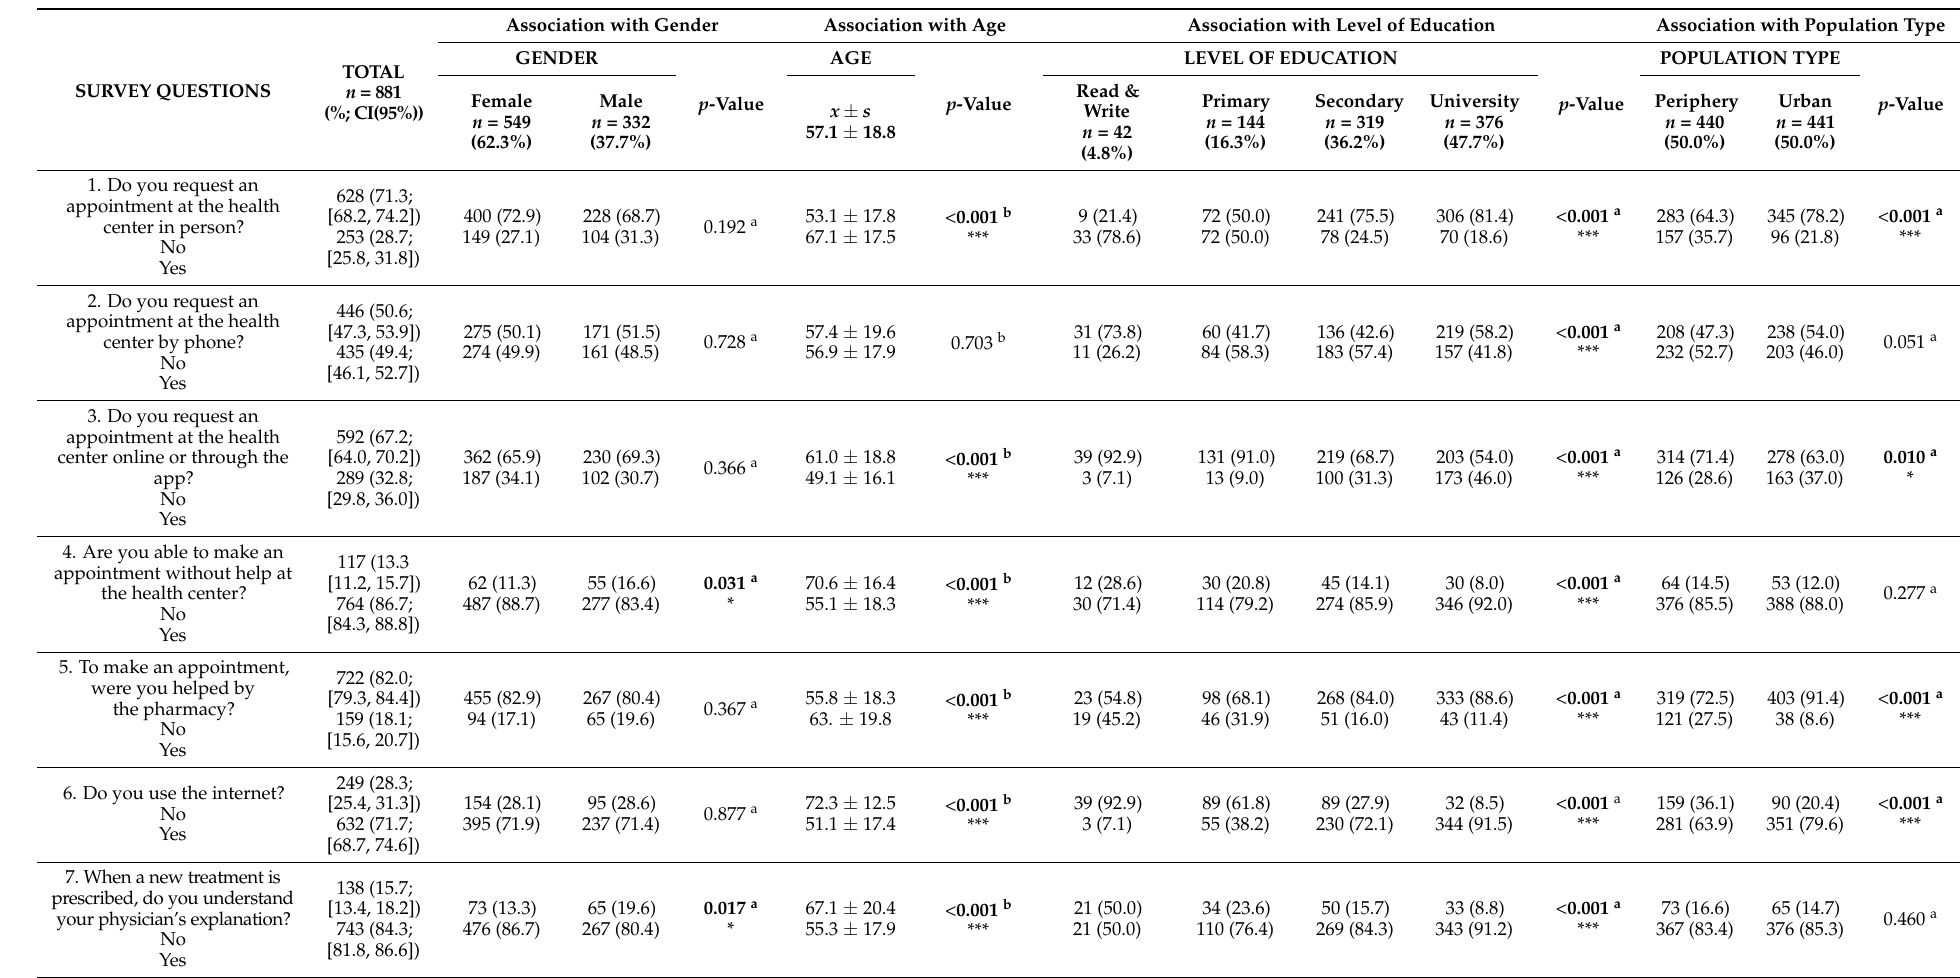
Table 3. Survey responses based on the participants’ gender, age, education level, and population